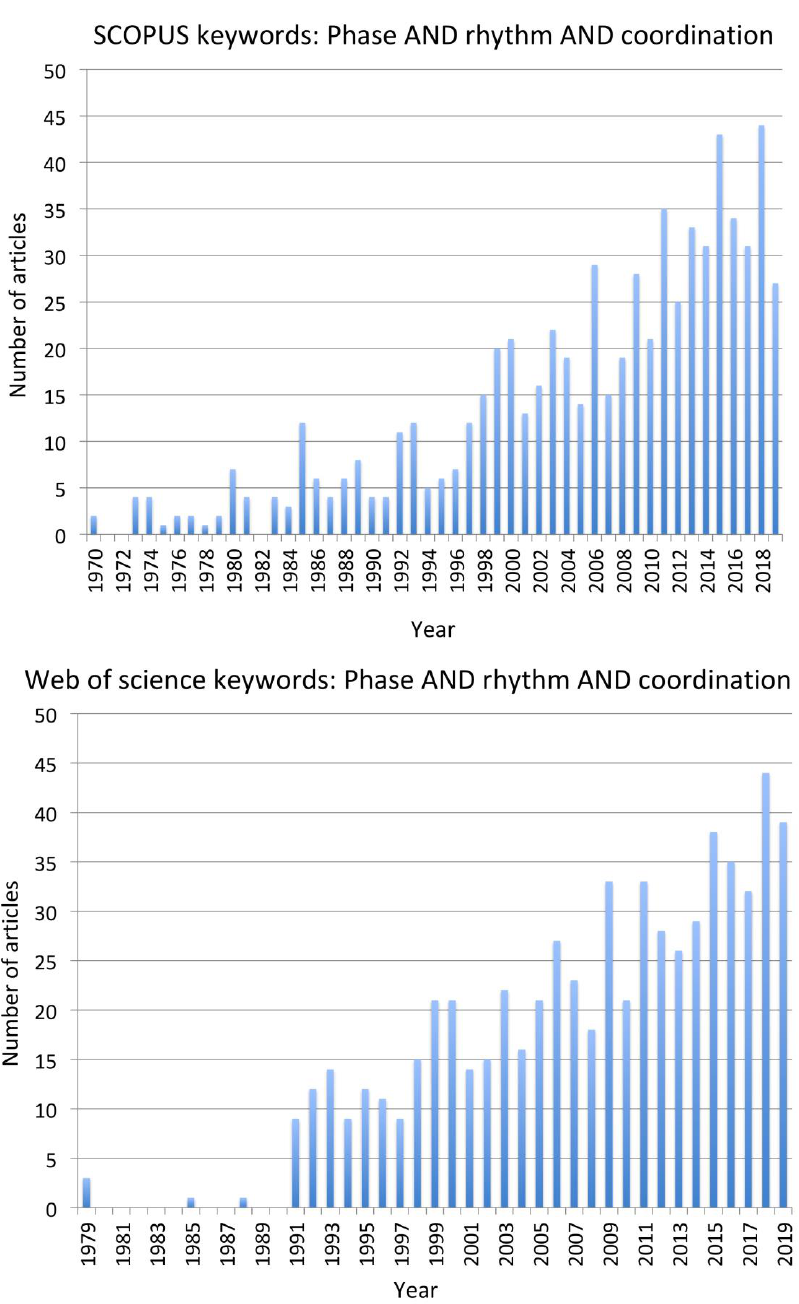
Figure 1. Frequency of publications matching the keywords “phase AND rhythm and coordination” in SCOPUS and Web of Science databases from 1979 to 2019.